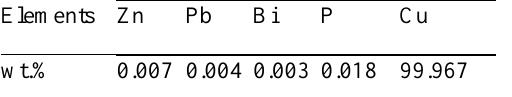
Table 2. Chemical composition of Copper C12200-H01.